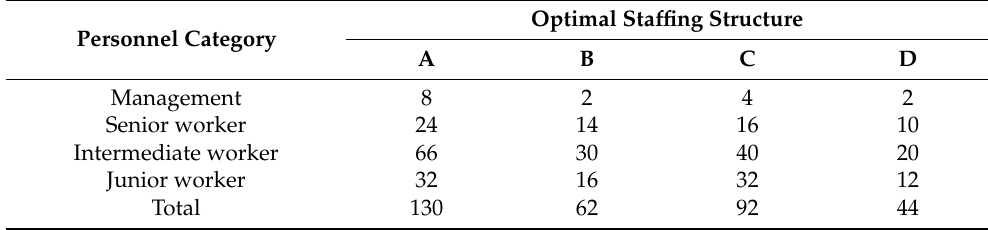
Table 5. Optimal staffing structure.